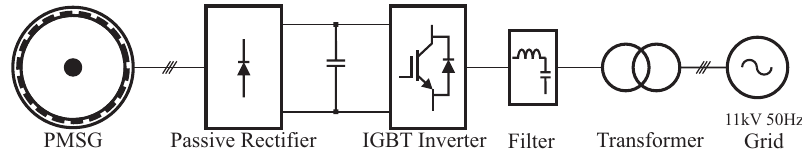
Figure 6. Converter system for the 200 kW